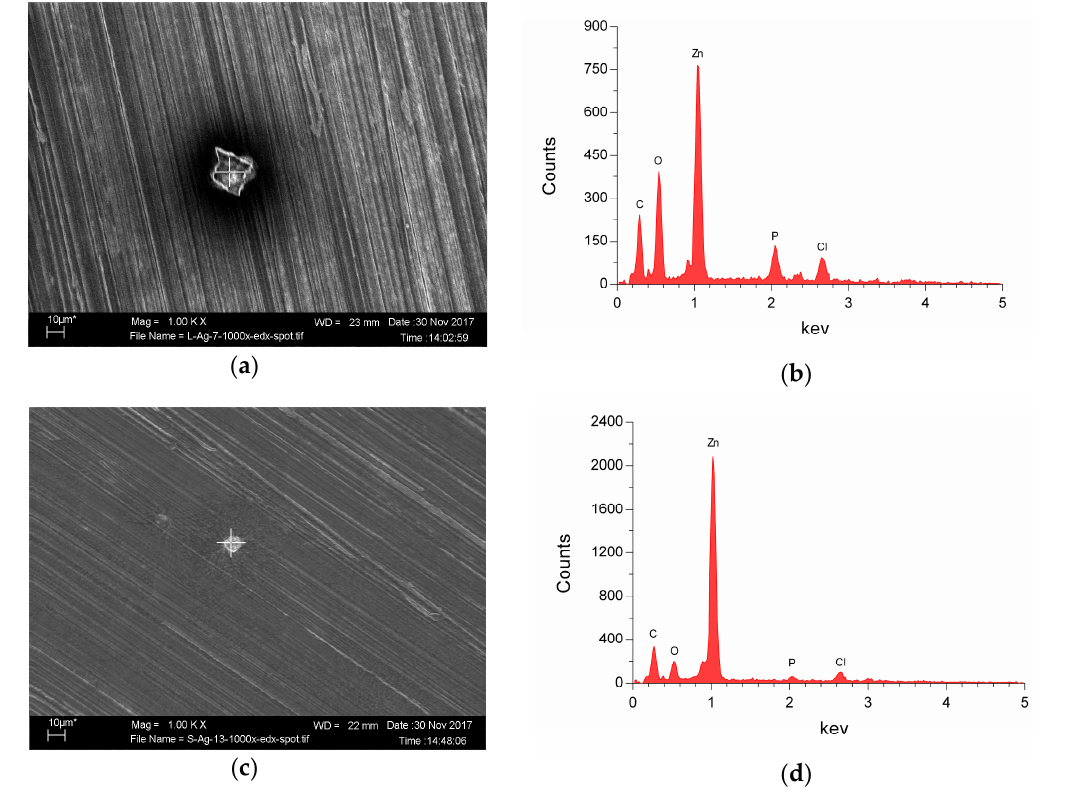
Figure 6. The SEM-EDX analysis of the Zn-4Ag alloy after immersion in DMEM/McCoy’s 5A for 24 h: ( a ) SEM images of Zn-4Ag alloy in DMEM (magnification 1000×); ( b ) EDX result of the degradation products in ( a ); ( c ) SEM images of Zn-4Ag alloy in McCoy’s 5A (magnification 1000×); and ( d ) EDX result of the degradation products in ( c ).